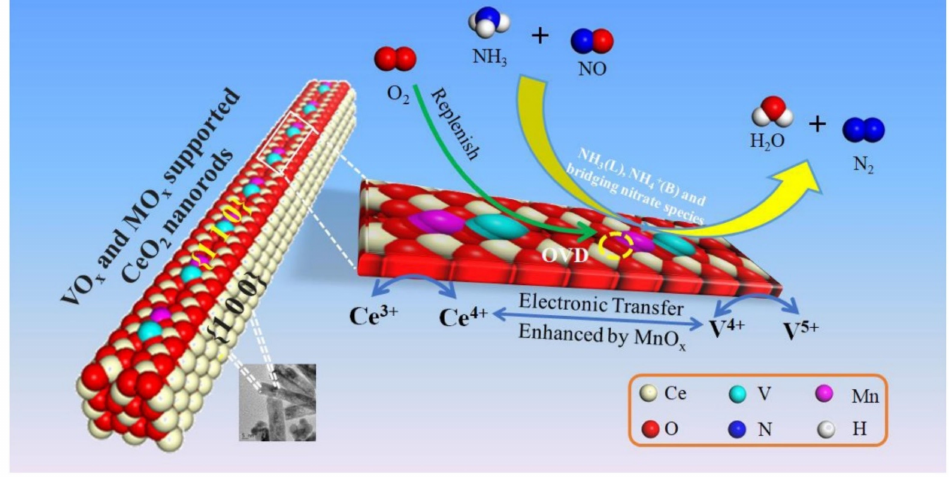
Figure 7. The possible mechanism of the VO x -MnO x /CeO 2 catalyst. Reproduced with permission from Reference [83]; copyright (2020),